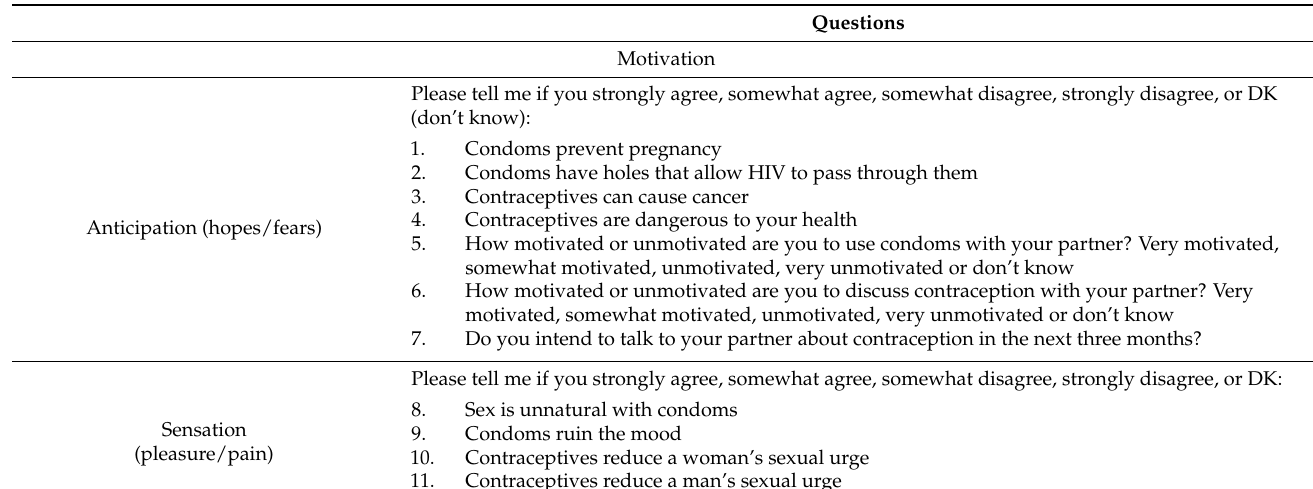
Table 2. Nigeria survey questions related to the Fogg Behavior